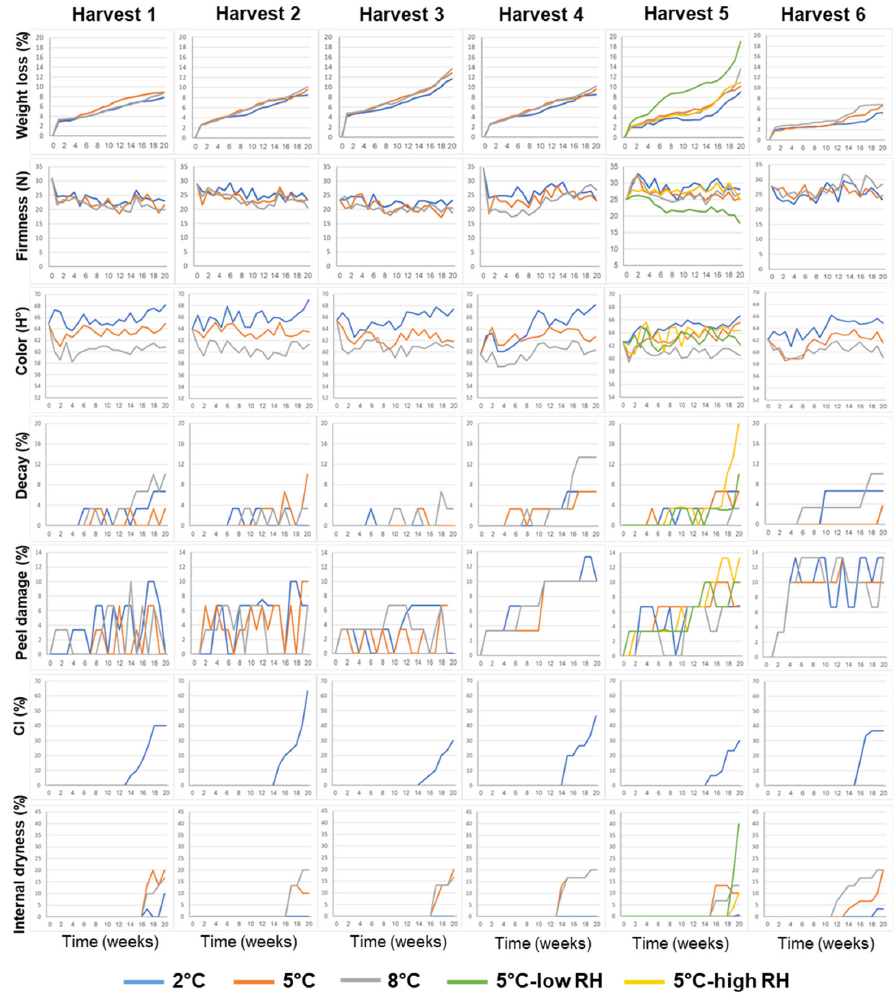
Figure 1. Effects of various pre-harvest and postharvest features on the postharvest storage quality of ‘Rustenburg’ navel oranges harvested from six different orchards. The harvest times and yields of the different orchards are presented in Table 1. The postharvest features included storage temperature (2, 5 or 8 °C) and storage RH level (70, 90 or 95%). Fruit quality was evaluated every week after one additional week of storage under shelf conditions (at 20 °C) for a period of 20 weeks.